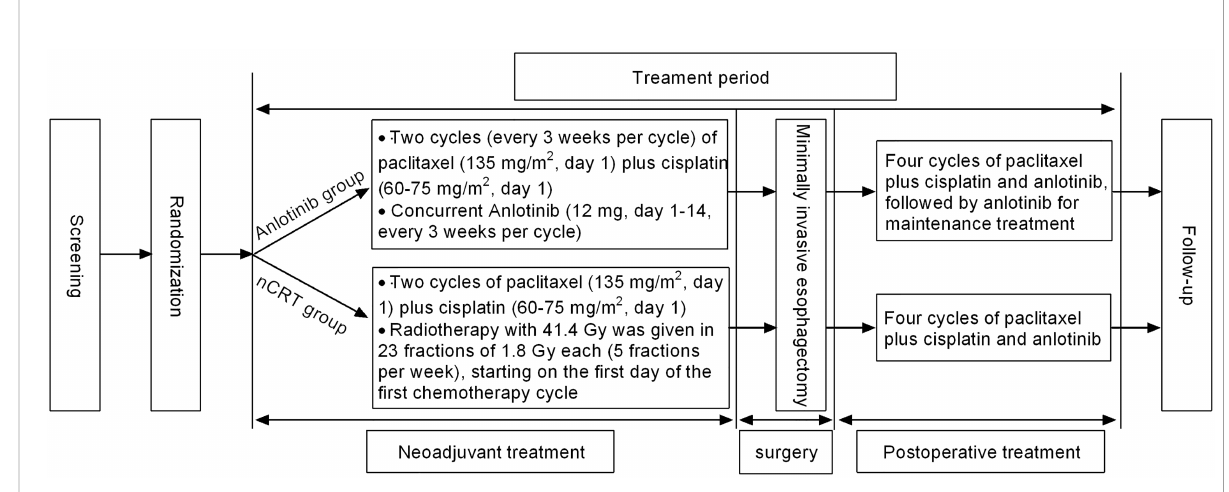
FIGURE 1 Study design. Anlotinib group, neoadjuvant Anlotinib combined with chemotherapy; nCRT group, neoadjuvant